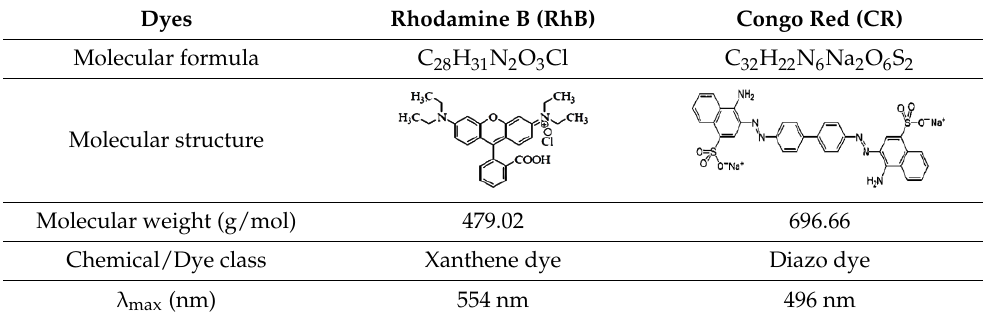
Table 1. Properties of synthetic dyes.